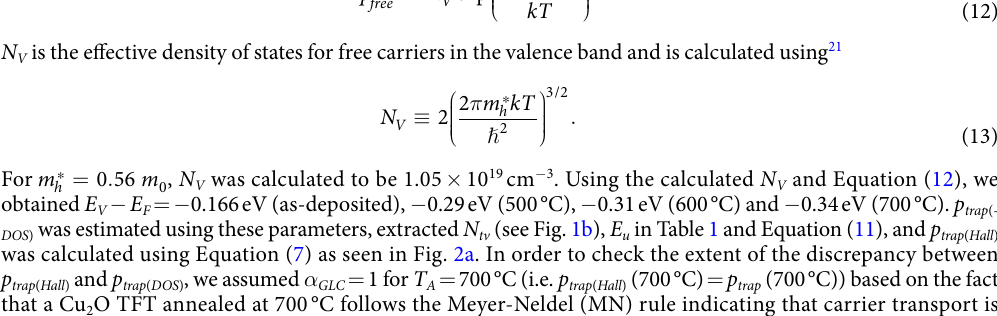
2 O TFT annealed at 700 °C follows the Meyer-Neldel (MN) rule indicating that carrier transport is